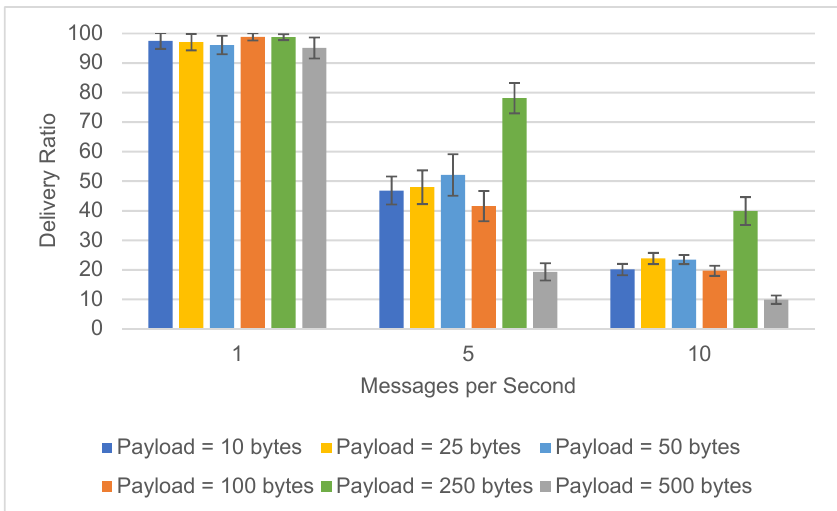
Figure 13. Delivery ratio (%) of messages (2 sensors and 1 destination).